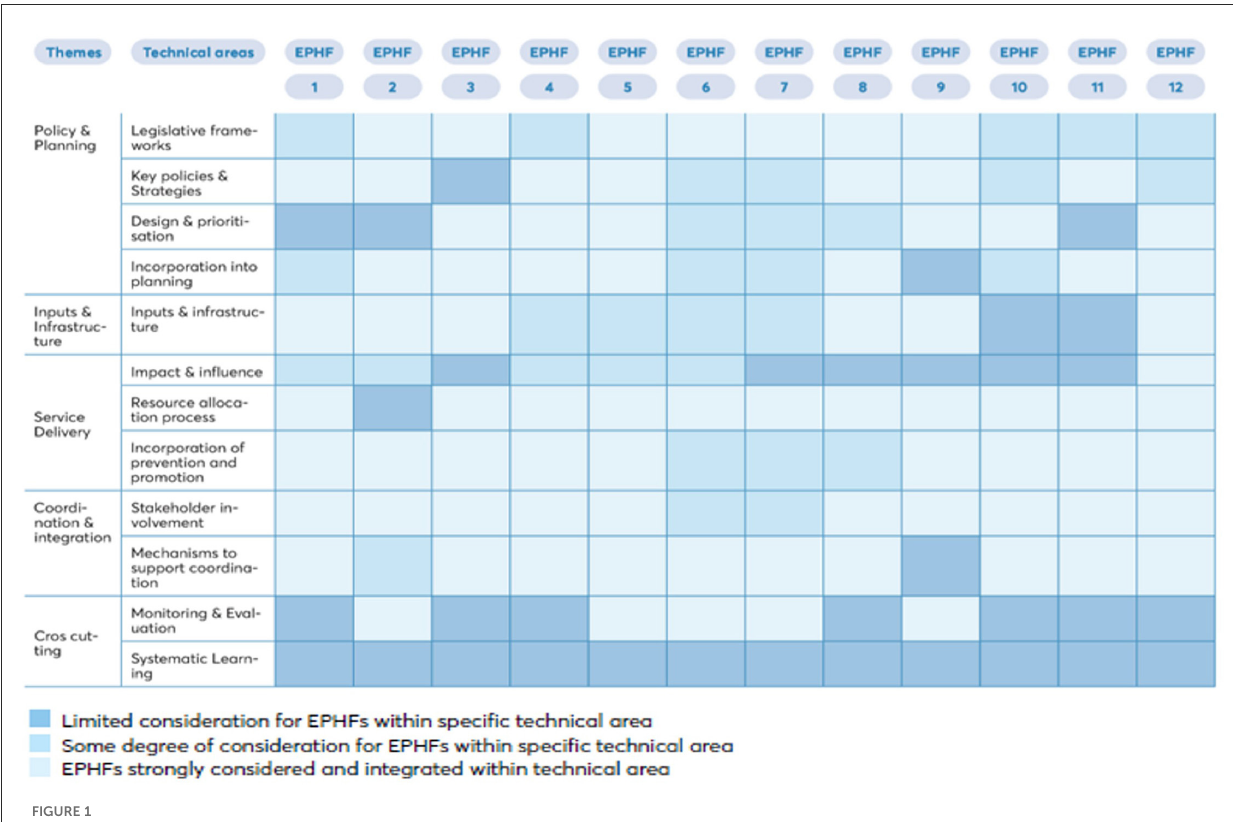
FIGURE1 Visual representation of mapping of individual EPHFs against key technical areas.